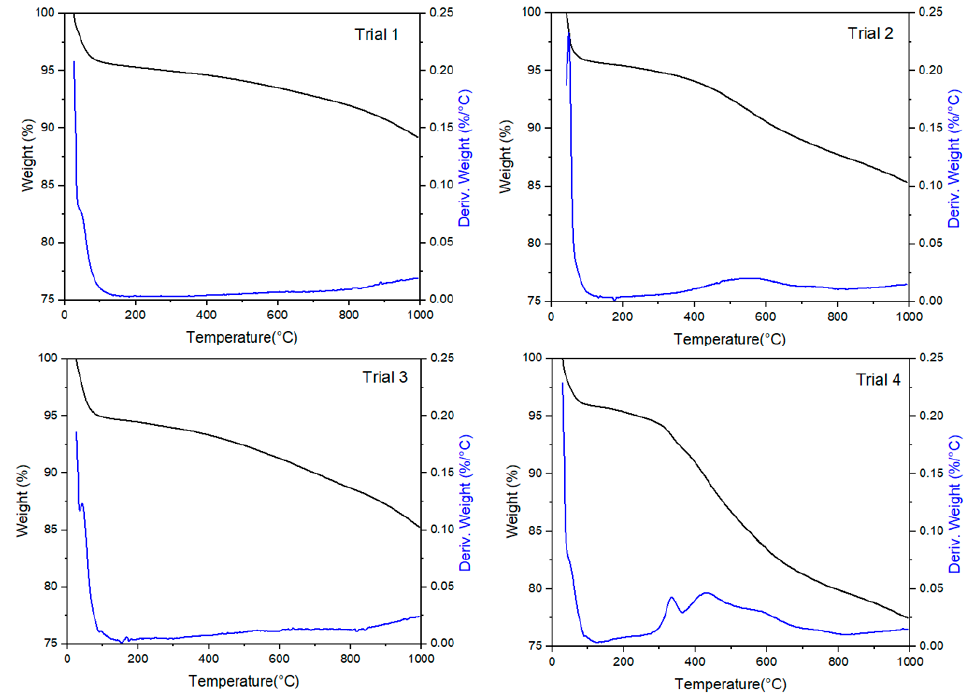
Figure 9. TGA and DTG curves for biochar samples obtained in each trial.